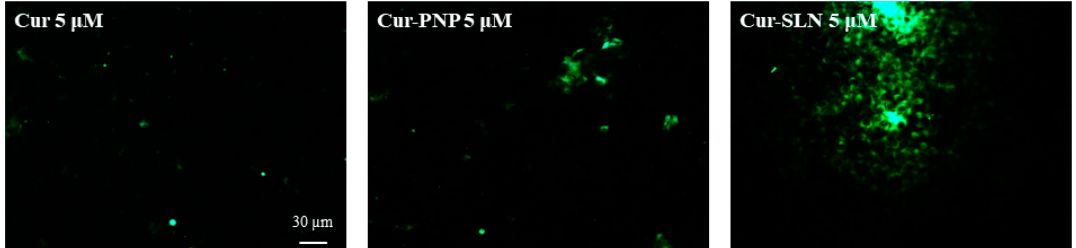
Figure 5. The internalization and uptake of free Cur, Cur-PNP and Cur-SLN into OECs at 5 µM. Scale bar: 30 µm.